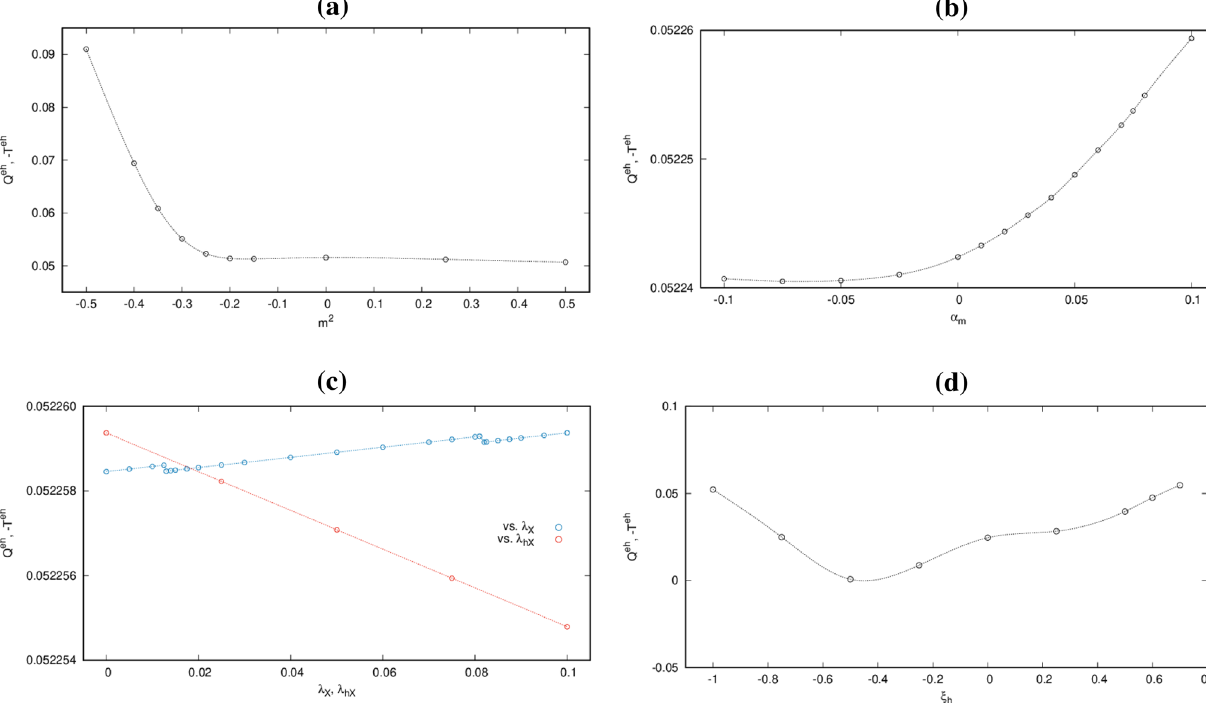
Fig. 14 The black hole charges related to the U ( 1 ) gauge fields, Q eh and T eh , as functions of a m 2 , b α m , c λ X ,λ hX and d ξ h , for evolutions with one non-minimal scalar–gravity coupling and non-varying parameters as in Fig.